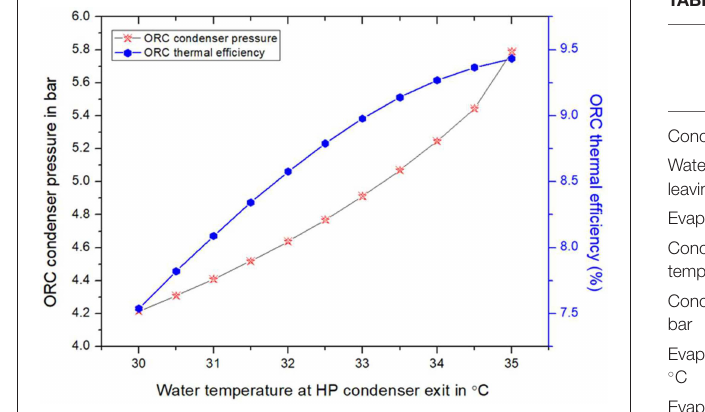
TABLE 1 | Combined cycle parameters by ASPEN and MATLAB